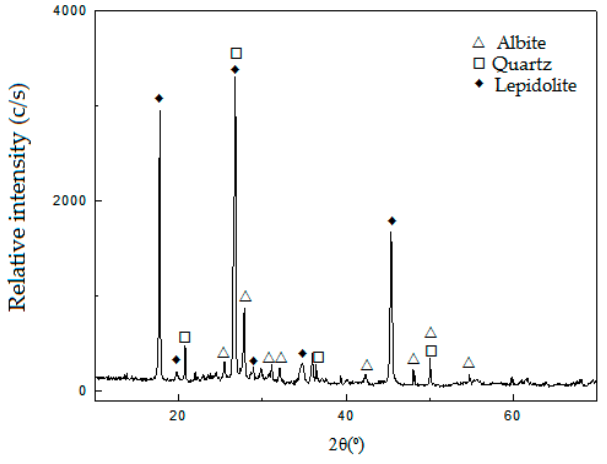
Figure 1. XRD pattern of the lepidolite concentrate.